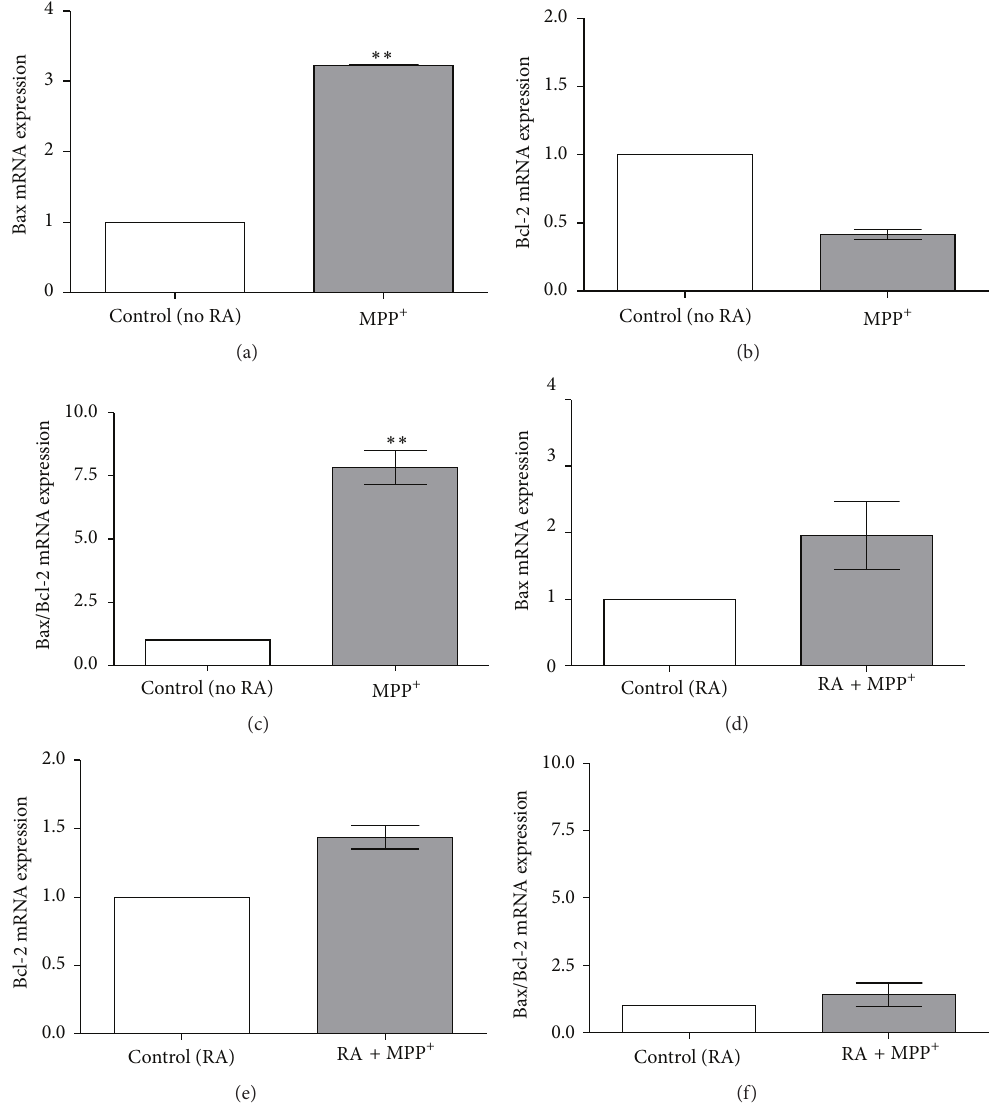
Figure 5: Effect of MPP + on Bax and Bcl-2 mRNA expression in undifferentiated and differentiated SH-SY5Y cells. Cells were differentiated in 10- 𝜇 M retinoic acid (RA) for 3 days. Undifferentiated (a–c) and differentiated cells (d–f) were exposed to 500 and 1000 𝜇 M of MPP + for 24 hours, respectively. Expression of Bax mRNA (a and d), Bcl-2 mRNA (b and e), and Bax/Bcl-2 ratio (c and f) was analyzed with quantitative real-time RT-PCR, relatively compared to their respective untreated controls. The expression levels of the target gene were normalized to the expression level of 𝛽 -actin. Data are expressed as mean ± SEM ( 𝑛 = 3 ). ∗∗ 𝑃 < 0.01 .